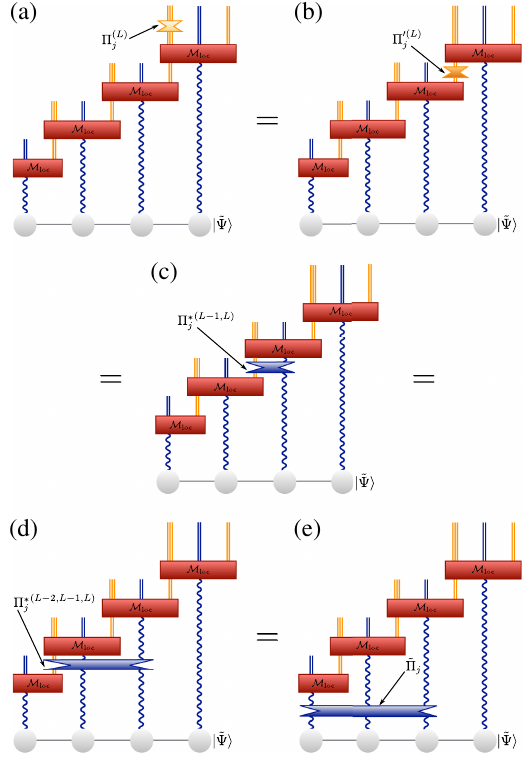
FIG. 15. (a) The action of a projector onto a given sector of flux j , for an intermediate link on the full basis. For physical states, it can be pulled through the basis changing isometries (b) – (d), and expressed in the reduced basis as a projector onto the corre- sponding sum of q α values for the vertices to the left of the target k link